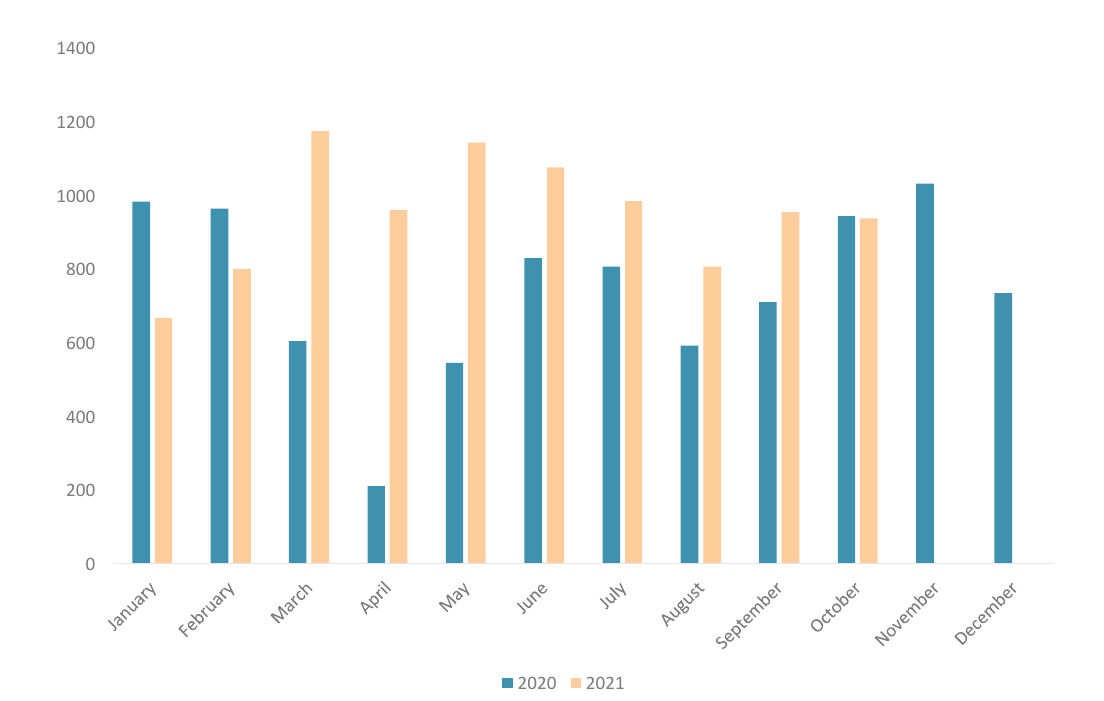
Figure 2. Number of endoscopic procedures performed in Alicante’s endoscopy unit in 2020 and 2021. Infection control strategy enable us to resume our pre-pandemic endoscopic activity rapidly.